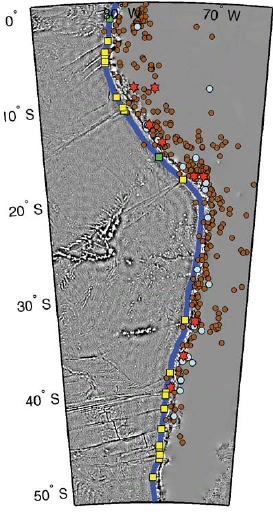
Fig. B6. Tectonic setting and key data for the Central American region. See Fig. B1 for